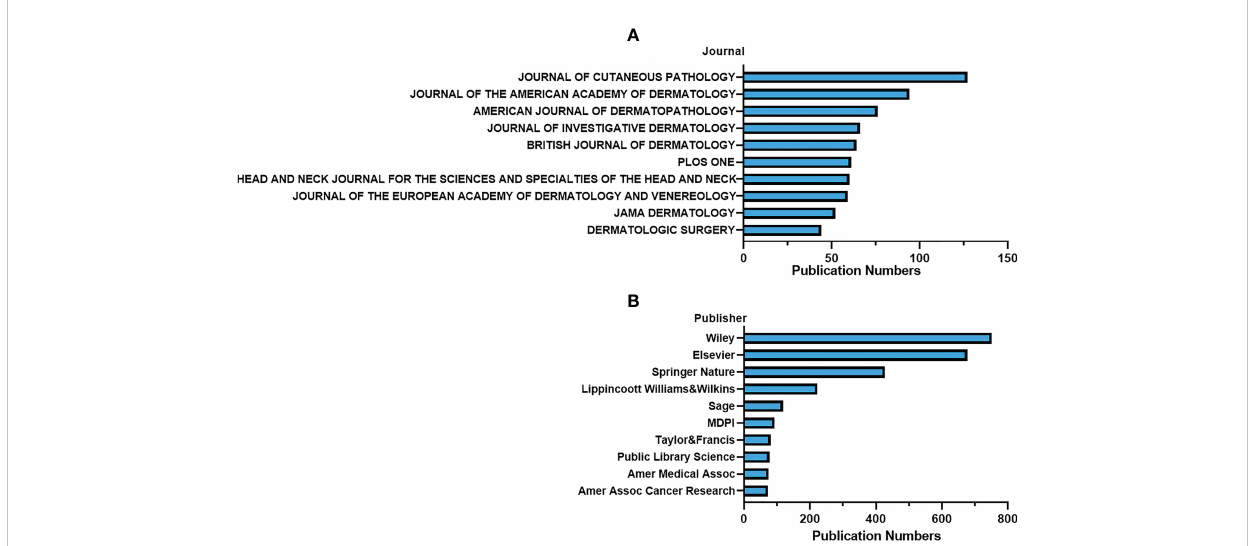
FIGURE 6 Statistic on the number of journals and magazines published. (A) .Statistical chart of the number of publications in journals. (B) .Statistical chart of the number of publications in publishers.